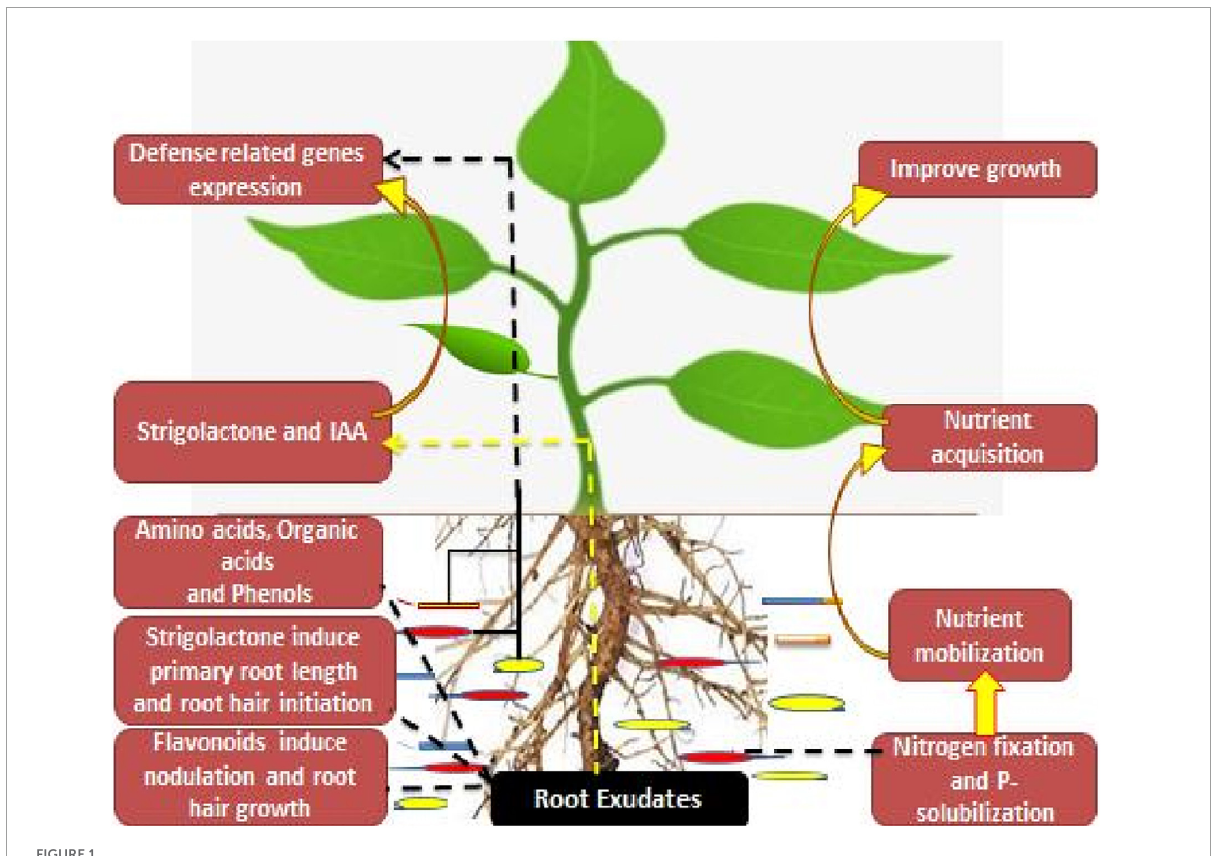
FIGURE1 Depicting root/rhizosphere and microbiome